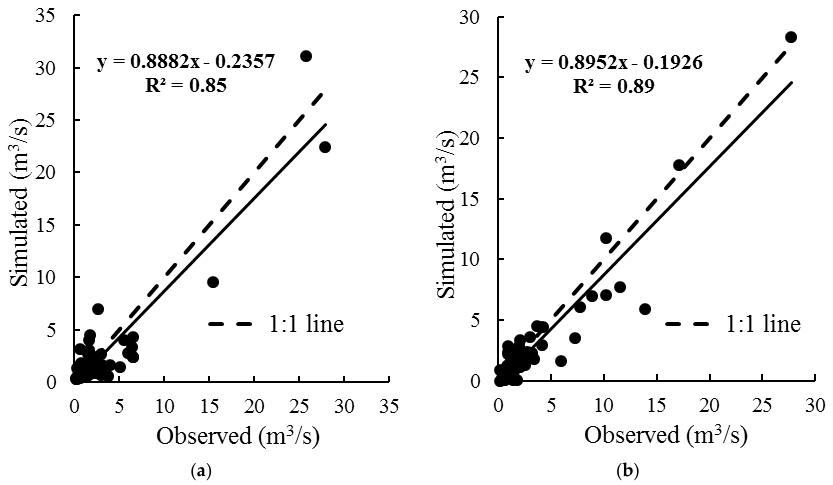
Figure 3. Comparison between simulated and observed monthly streamflow during the calibration ( a ) and validation ( b )